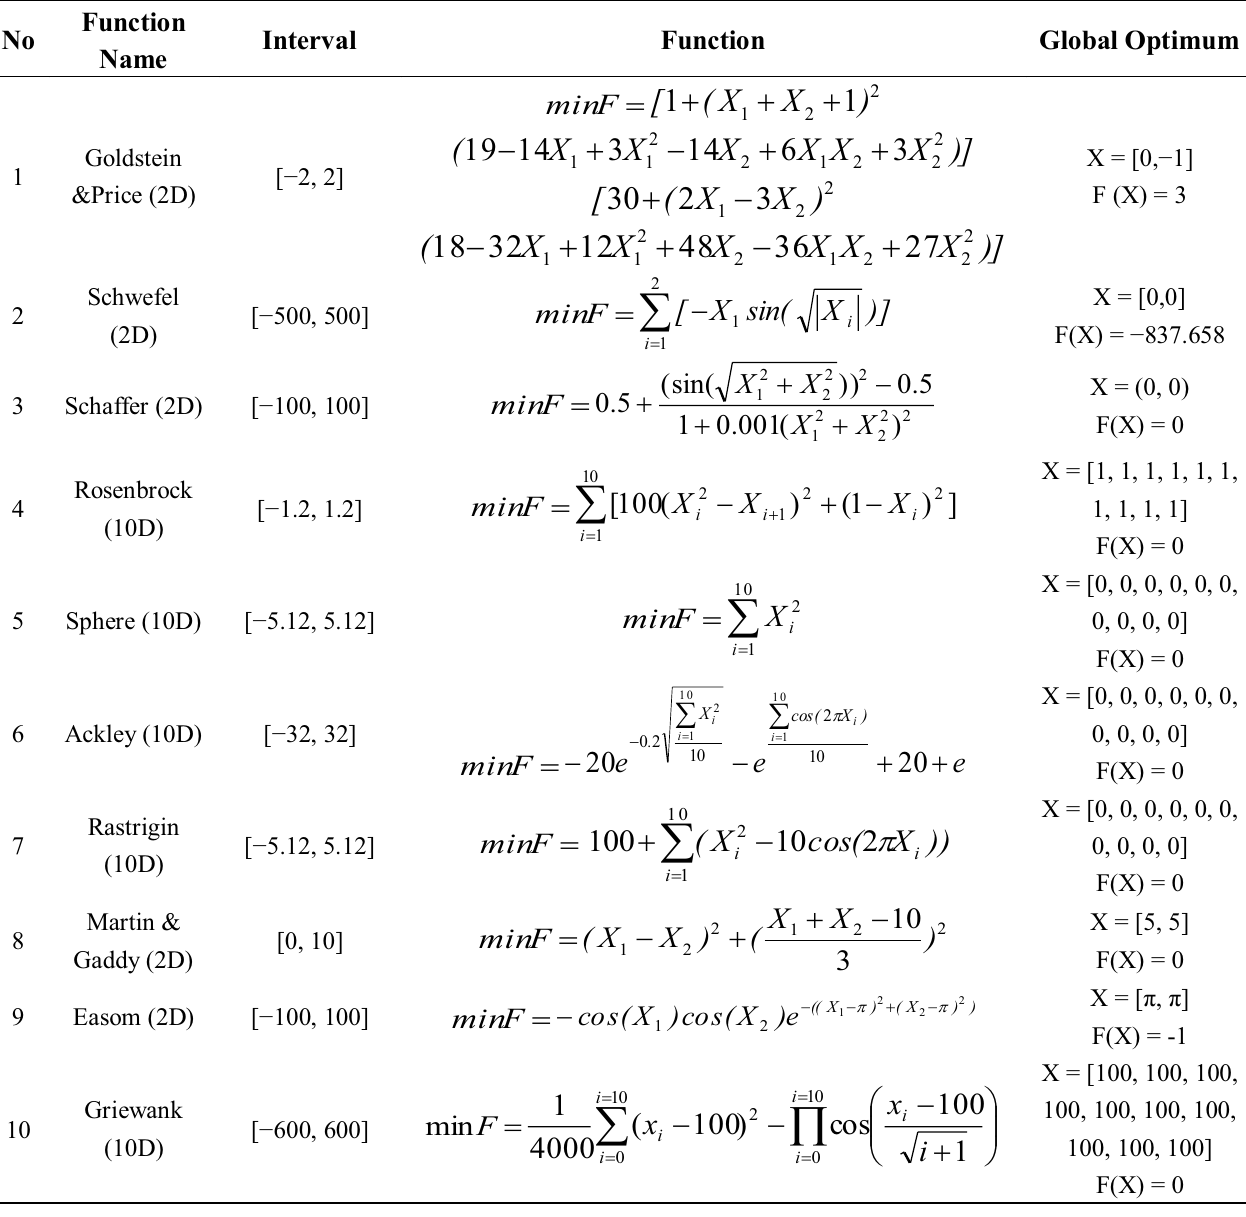
Table 2. The selected benchmark functions